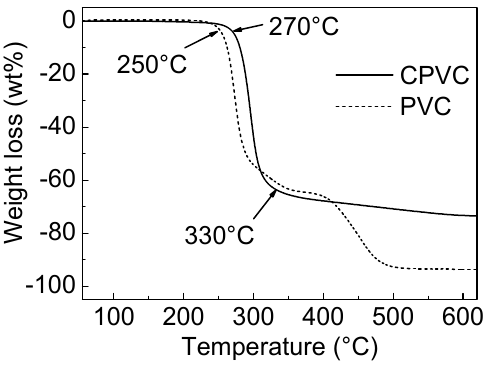
Figure 2. The thermogravimetric analysis (TGA) profiles of the chlorinated polyvinyl chloride (CPVC) and polyvinyl chloride (PVC) under N 2 flow.